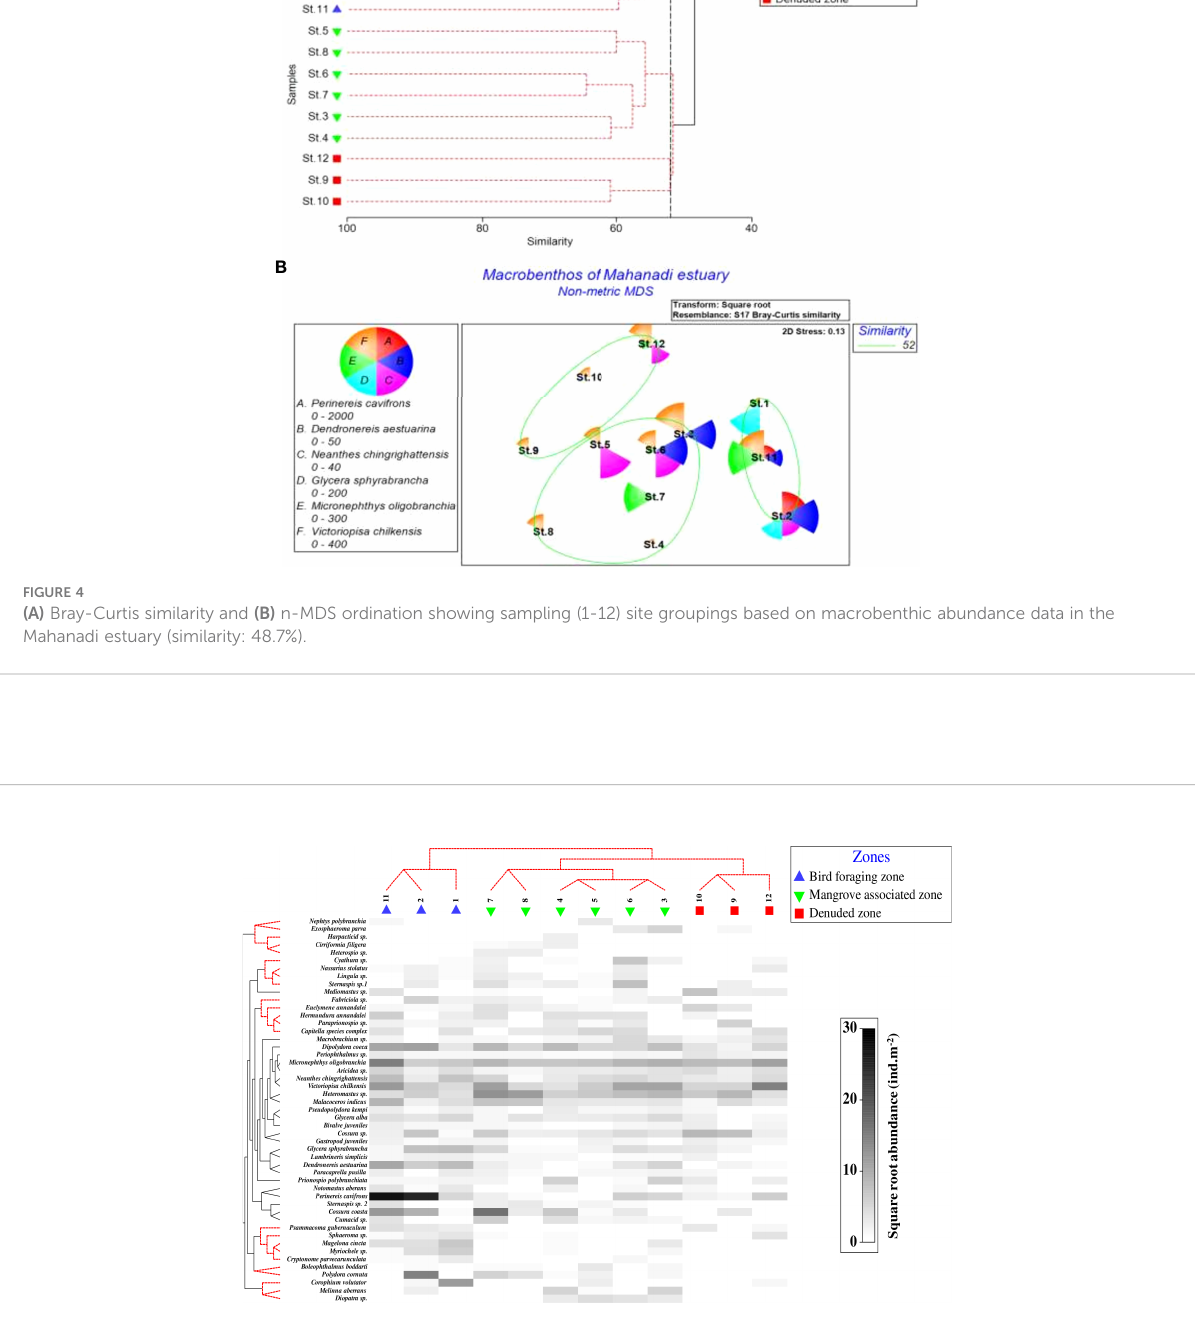
FIGURE 5 Macrobenthic communities of Mahanadi estuary in 2013-2017: Shade plot, a visual representation of abundances (averaged over seasons) of 49 macrobenthic species accounting for ≥ 1% or ˜ 1% of the total abundance at one or more sampling sites. Groups are named Bird foraging zone, Mangrove associated zone, and Denuded zone with linear greyscale intensity proportional to square root transformation abundance (ind.m -2 ). The three signi fi cantly different sub-clusters marked by SIMPROF-powered UNCTREE analysis (X-axis) are